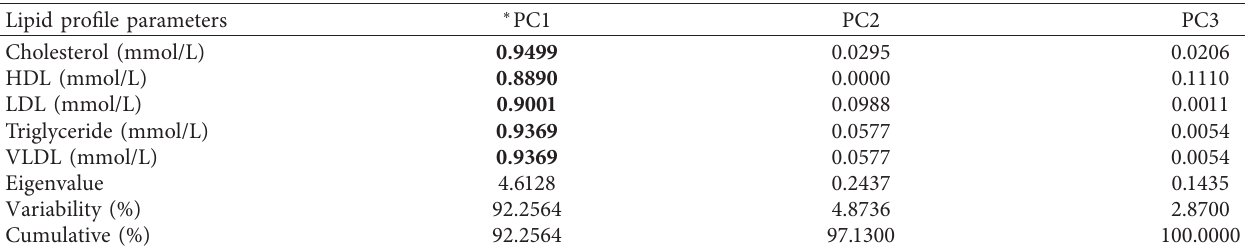
Table 3: Loadings of lipid profile variables on significant principal components after Varimax